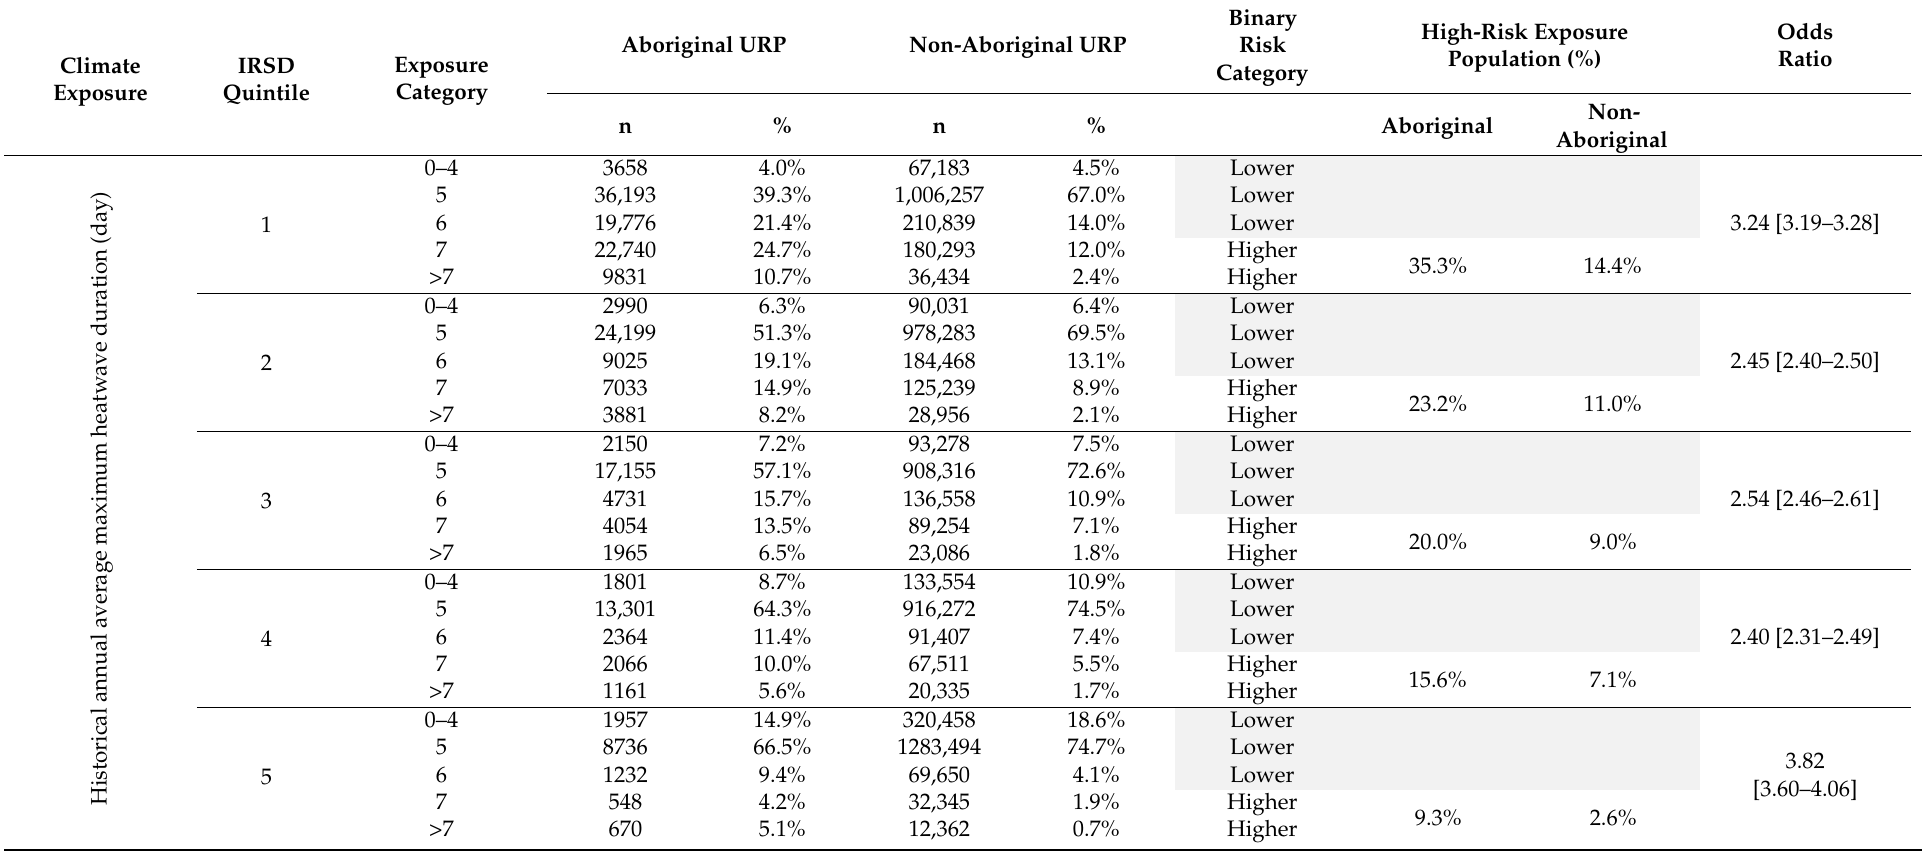
Table A2. Climate exposure estimates by Aboriginal versus non-Aboriginal usual resident populations stratified by the Index of Relative Socioeconomic Disadvantage (IRSD). Small cell counts for either population have been